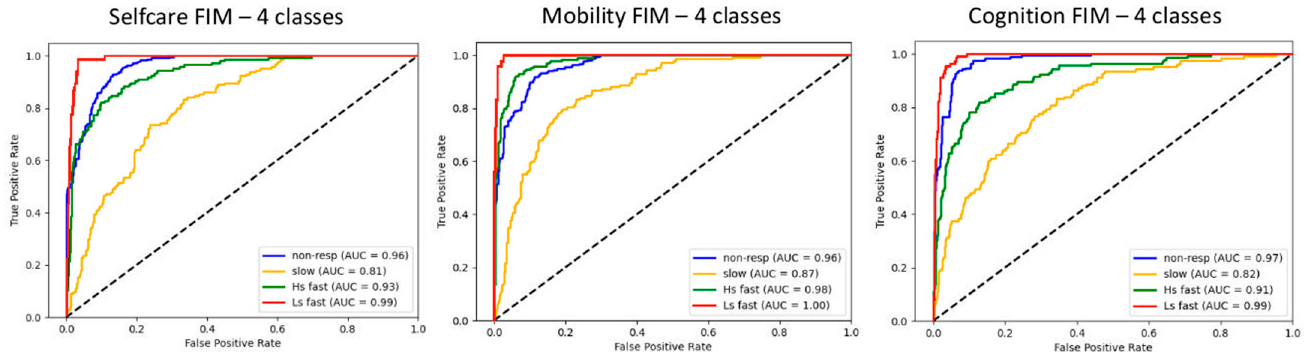
Figure 3. From left to right, prediction performance on previously unseen cases, among four classes of trajectories in each FIM domain: selfcare, mobility and cognition. “non-resp” is non responders; “slow” is slow responders; “resp” is responders; “fast” is fast responders; “Hs” is high-start fast responders; and “Ls” is low-start fast responders.